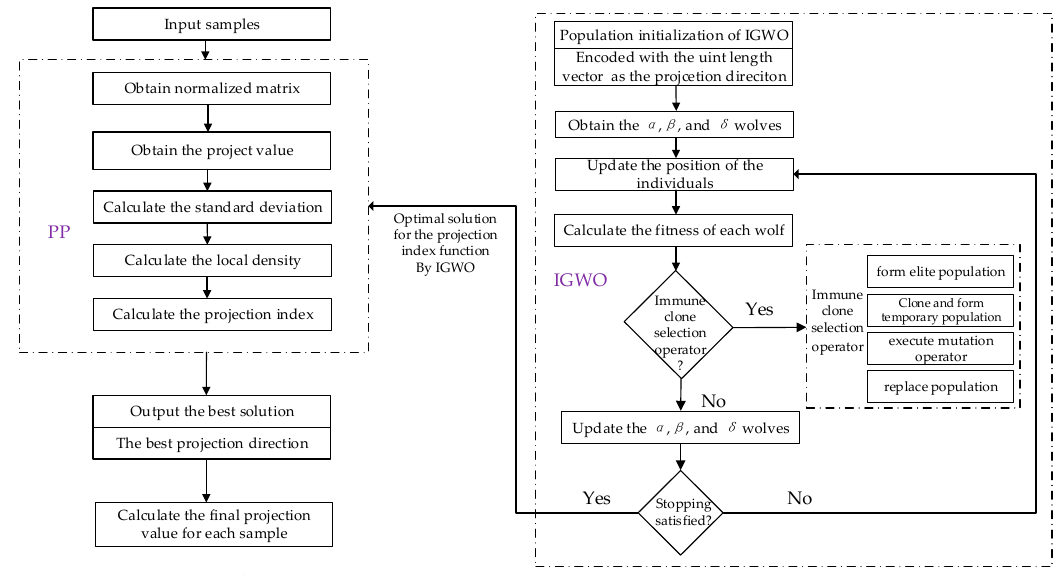
Figure 2. Principle of the immune grey wolf optimizer algorithm (IGWO) and its implementation flow.